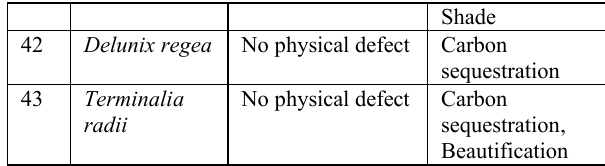
Table 2. Idi-Ishin Avenue Trees Physical Conditions and Benefits